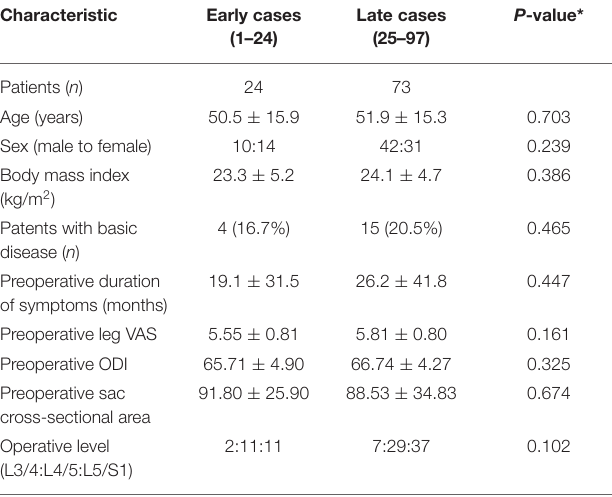
TABLE 3 | General characteristics stratified by learning period.